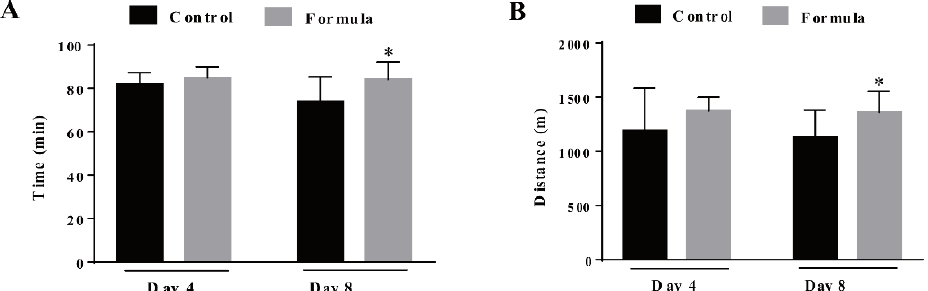
Figure 3. The time ( A ) and distance ( B ) required to reach exhaustion, measured during the exhaustive treadmill test in the control and formula groups. At 4 d, N = 12 mice in each group, at 8 d, N = 9 mice in the control group, and N = 12 mice in the formula group. Black column: control group and gray column: formula group. Data are expressed as mean ± SD, * p < 0.05, compared to the control group.